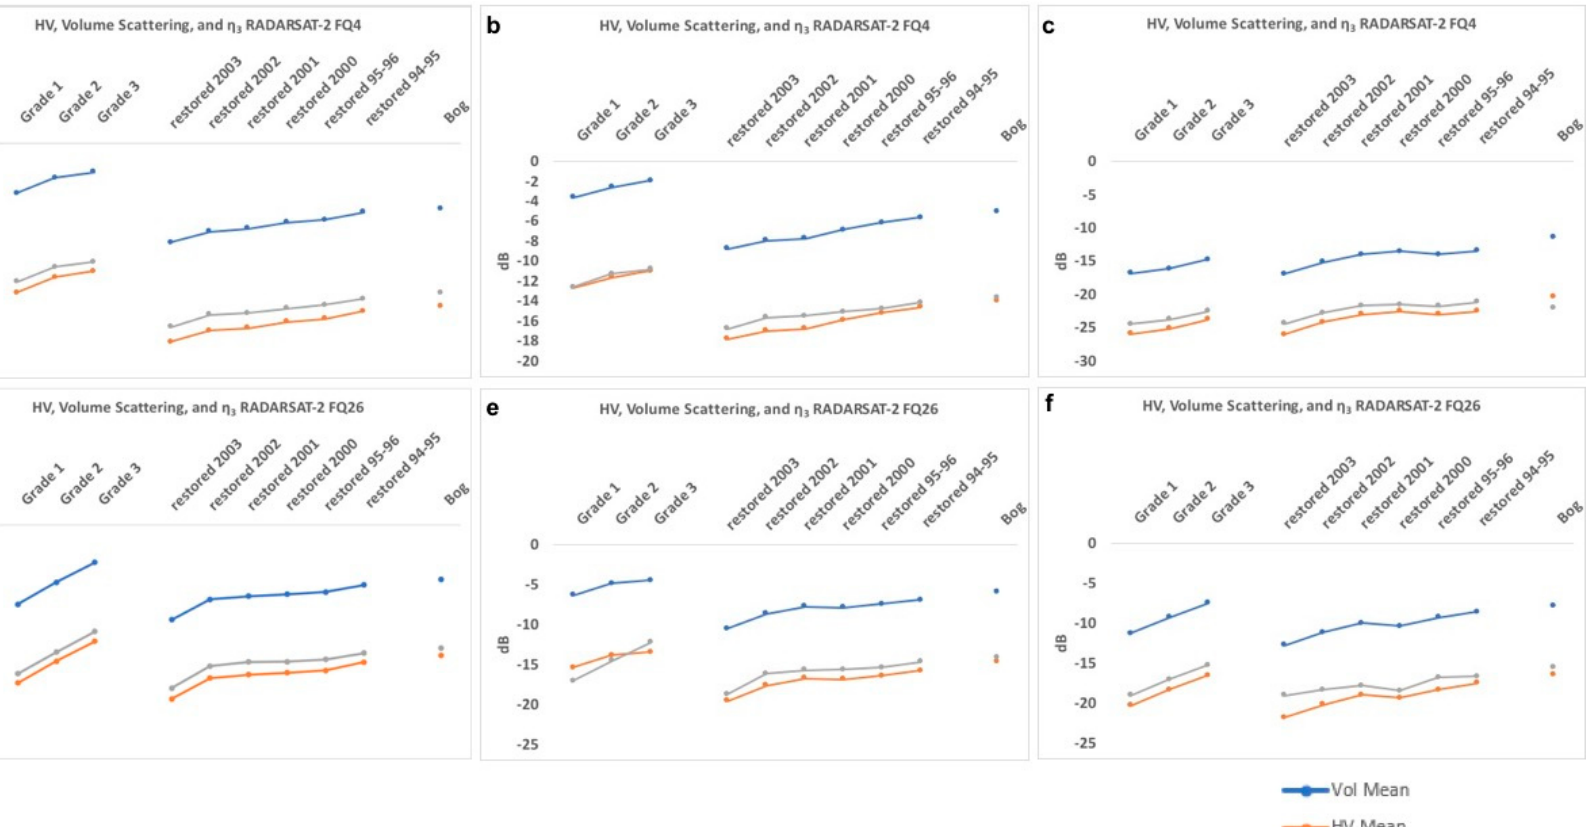
Figure 10. Comparison of dB values from HV intensity, the FD volume scattering, and the ICTD η 3 for July 15 FQ4 ( a ), August 22 FQ4 ( b ), October 19 FQ4 ( c ), July 18 FQ26